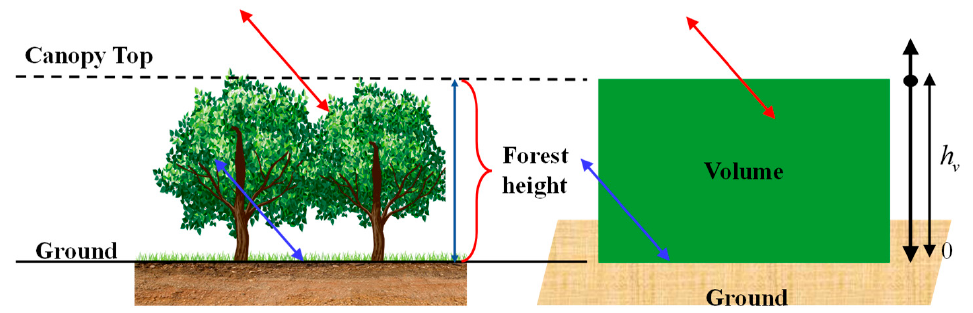
Figure 1. The RVoG model. Note that the red and blue arrows represent the volume and ground scattering procedure, respectively. phase center is located closer to the ground, i.e., µ ( ω ) → ∞ , and complex coherence is equal to the underlying ground phase: γ ( ω ) = e i φ 0 . At the other extreme, when the radar response is dominated by volume scattering, without the presence of the ground ( µ ( ω ) = 0), the complex coherence is equal to the volume-only coherence with the un- derlying ground phase: γ ( ω ) = e i φ 0 γ v . Therefore, from the perspective of the geometric interpretation, the RVoG model can be expressed as a linear function of both real and imag- inary parts of the polarimetric complex coherence set and corresponds to a line segment in the